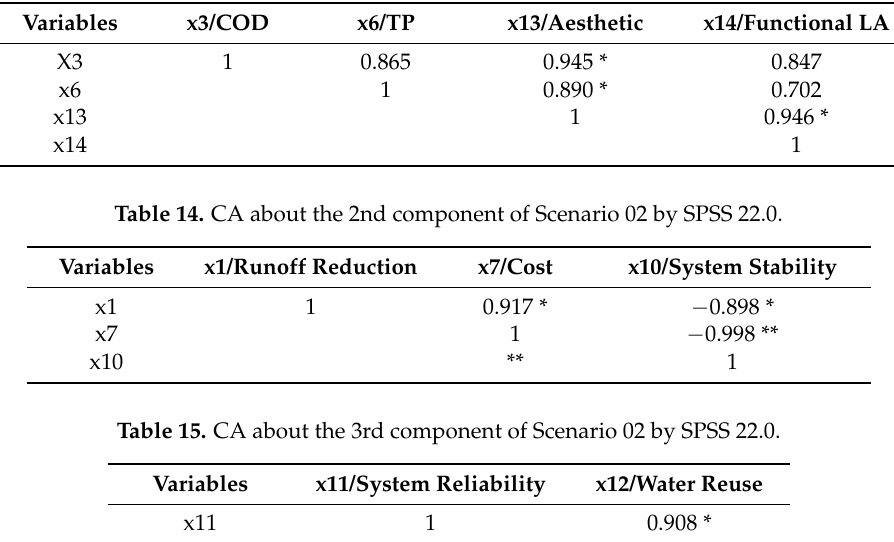
Table 13. CA about the 1st component of Scenario 02 by SPSS 22.0.